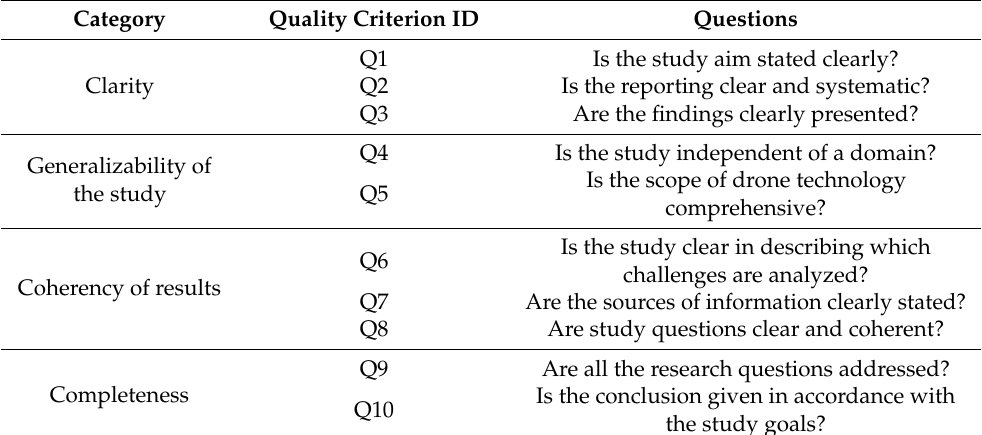
Table 3. Quality checklist.